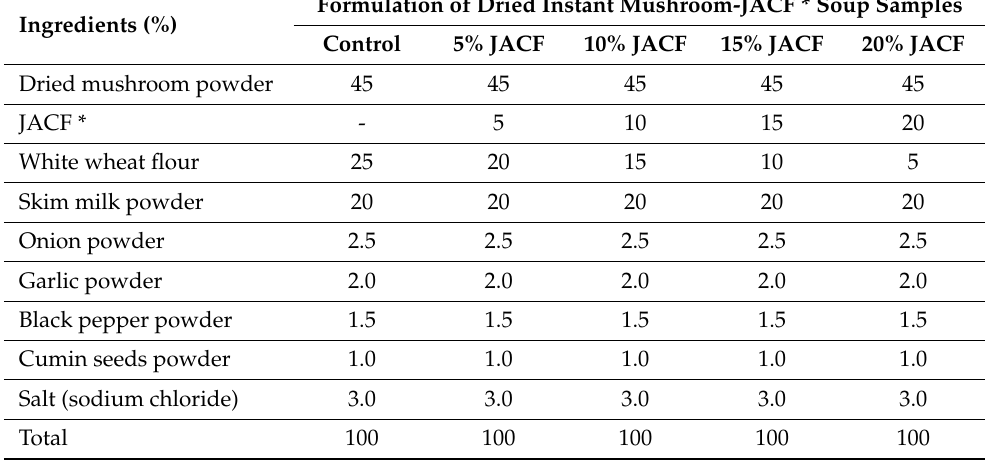
Table 1. Formulation of dried instant mushroom- JACF soup